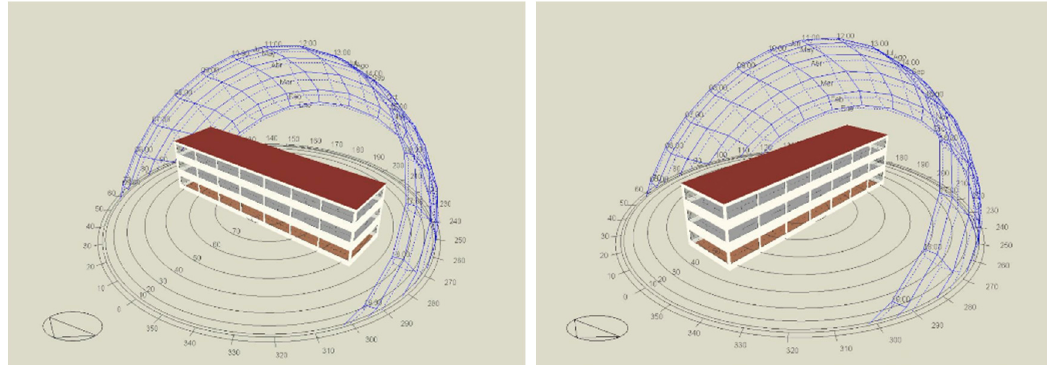
Figure 5. Building orientation simulations with relation to solar trajectory, fourth building. Orientation 90 degrees on the ( left ) and 0 on the ( right ).